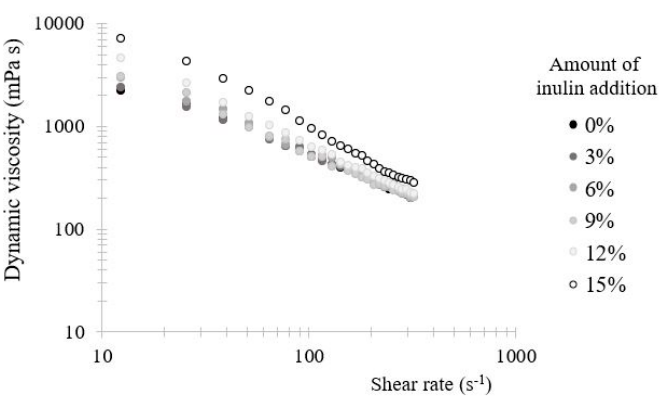
Figure 6. Viscosity curves of yogurts with 0%, 3%, 6%, 9%, 12% or 15% w / w inulin addition.